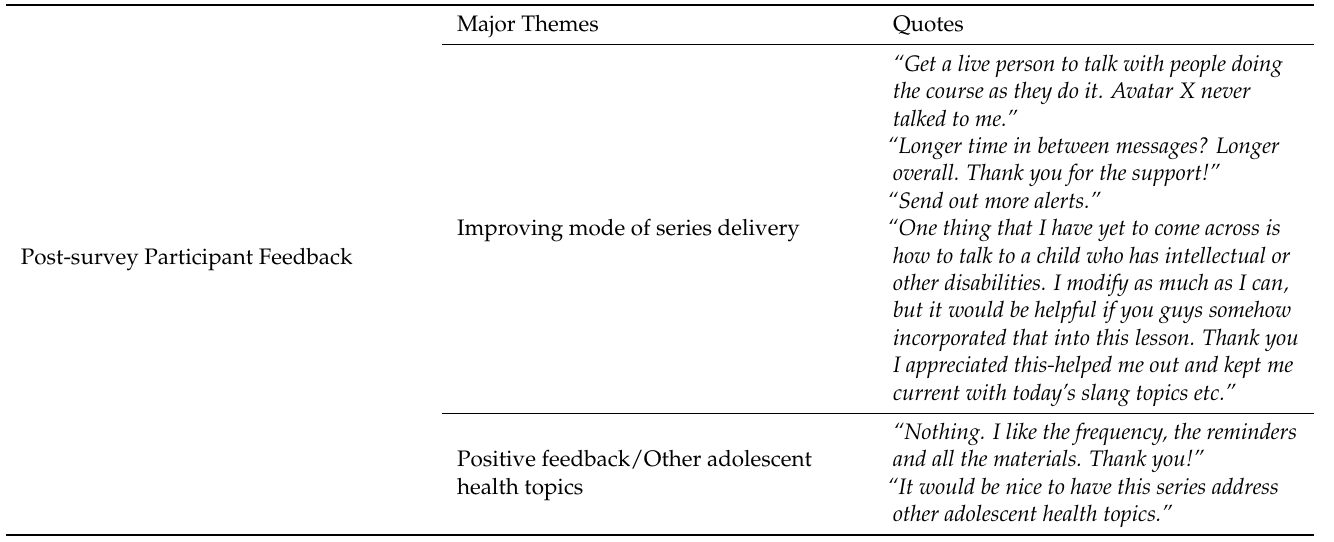
Table 5. Post-survey Participant Feedback Qualitative Themes and